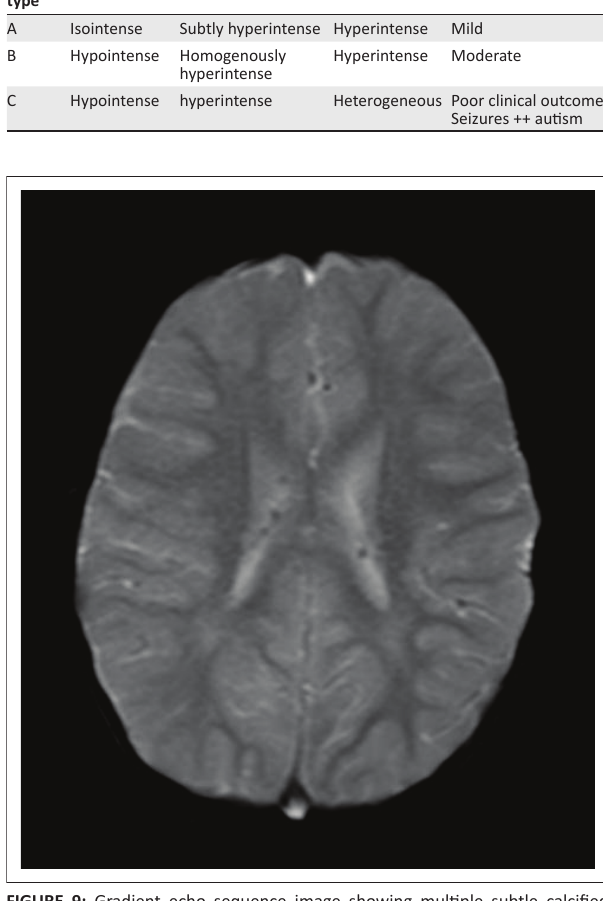
FIGURE 9: Gradient echo sequence image showing multiple subtle calcified subependymal nodules.